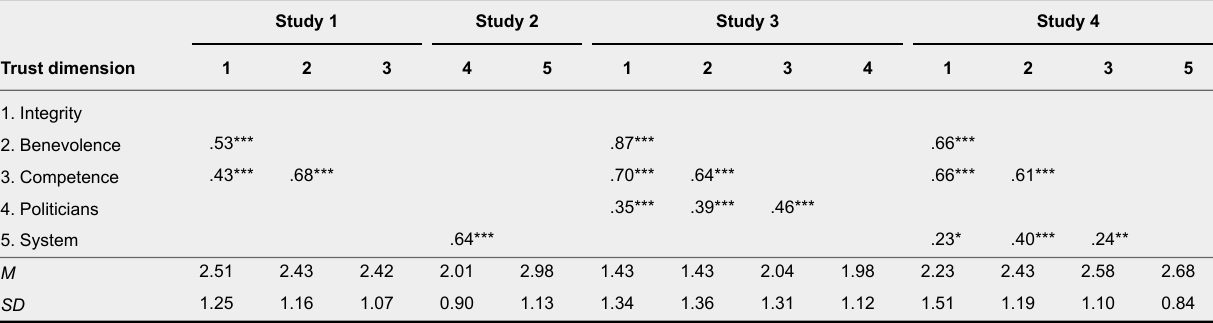
Means, Standard Deviations, and Correlations in Study 1 to